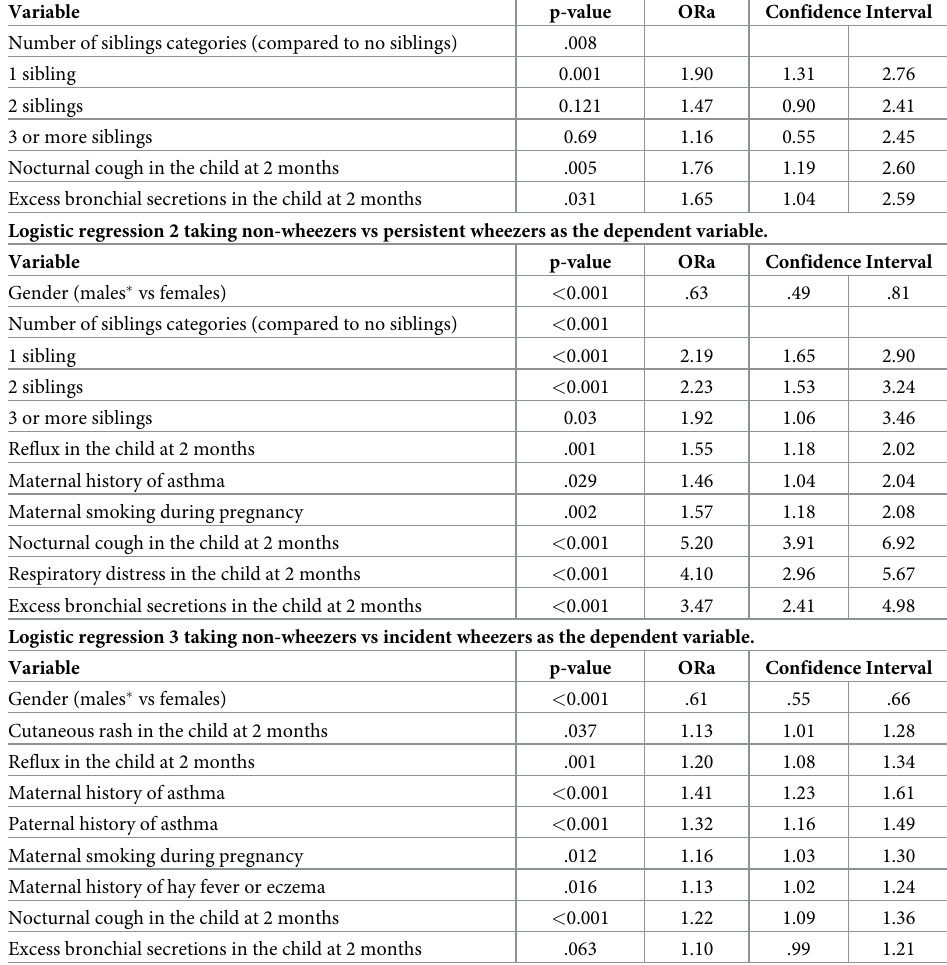
Table 6. Multivariable analysis. Logistic regression 1 taking intermittent vs persistent wheezers as the dependent variable (with the respiratory symptoms at 2 months as independent variables).